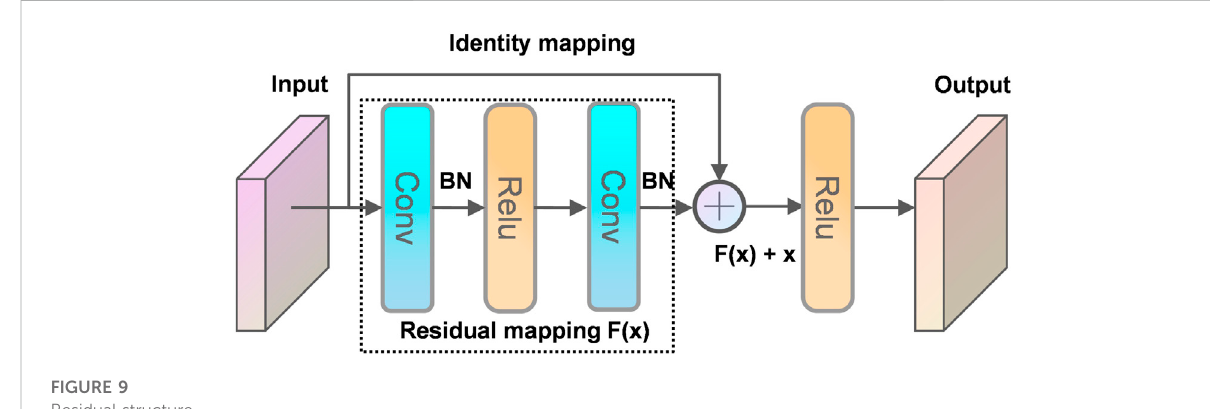
FIGURE 9 Residual structure.